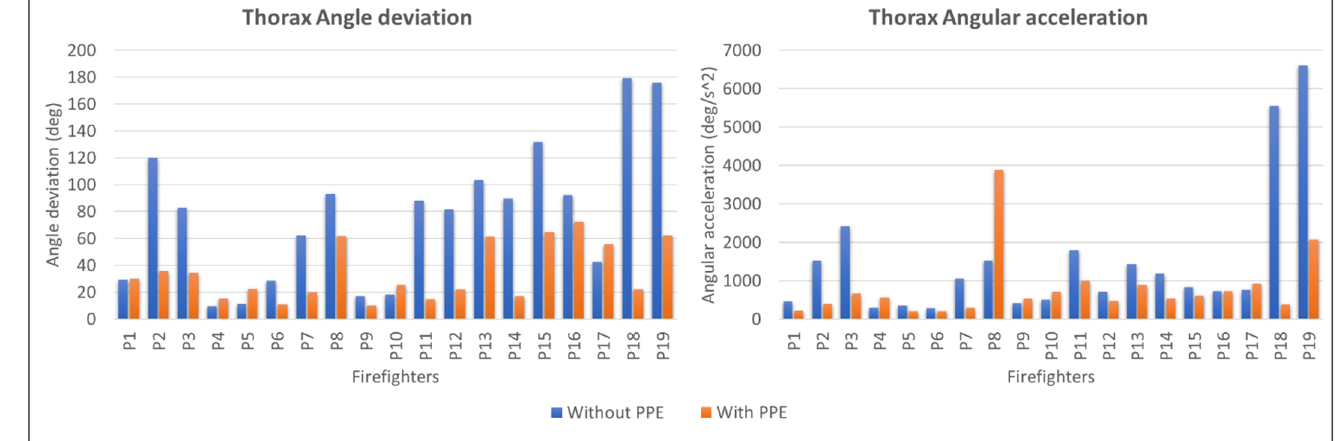
Figure 6. Thorax angle deviation and thorax angular acceleration during lifting. Table 2. Comparison statistical